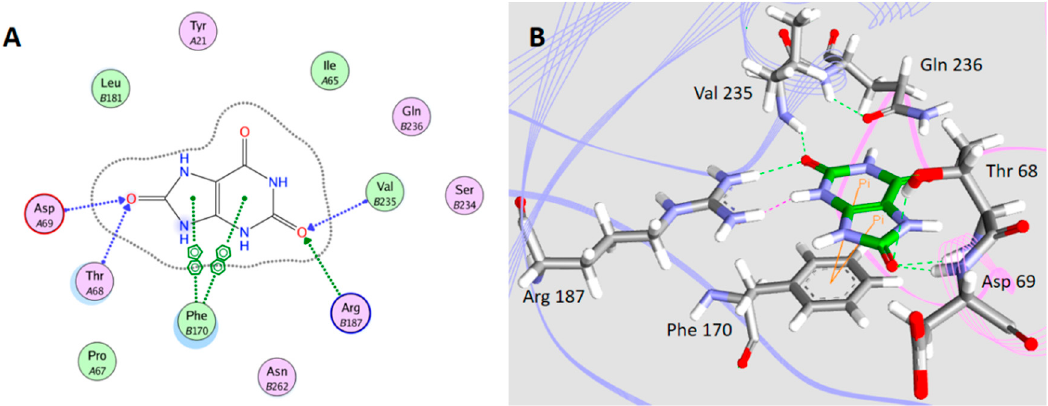
Figure 7. Structure modeling of uric acid to H 1-2 P 3 H 4 P 5-6 H 7-8 (E24D & E83G) is illustrated in both 2D and 3D view ( A , B ). In 2D views, intermolecular interactions between the receptor and the ligand are illustrated, with ( A ) and ( B ) indicating amino acid residues from different subunits. In 3D views, both uric acid and amino acid residues involving in the binding are shown as stick structures. Subunit ( A ) is shown in pink whereas unit ( B ) is shown in blue. The carbon atoms in uric acid are shown in green, the carbon atoms in amino acid residues are shown in gray, the oxygen atoms are shown in red, and the nitrogen atoms are shown in blue.